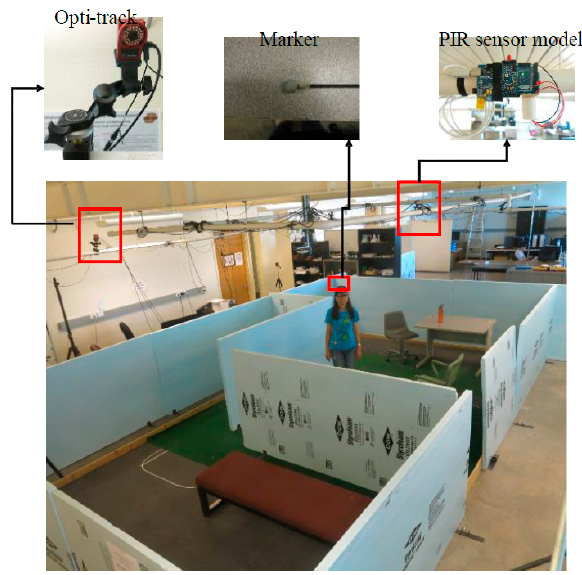
Figure 10. Testbed with Opti-track System and PIR sensors.